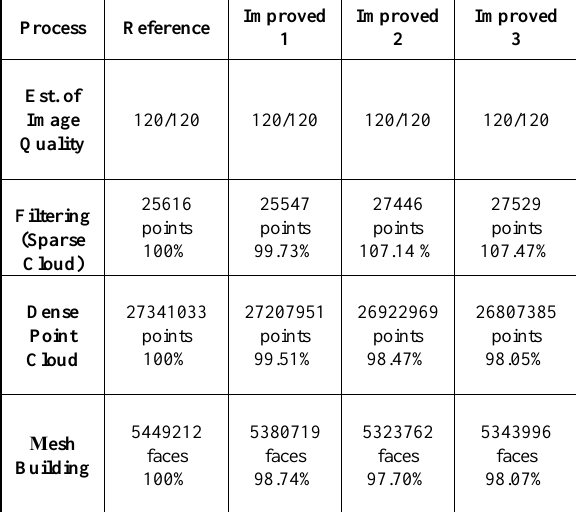
Table 5. The results of the 3D modeling